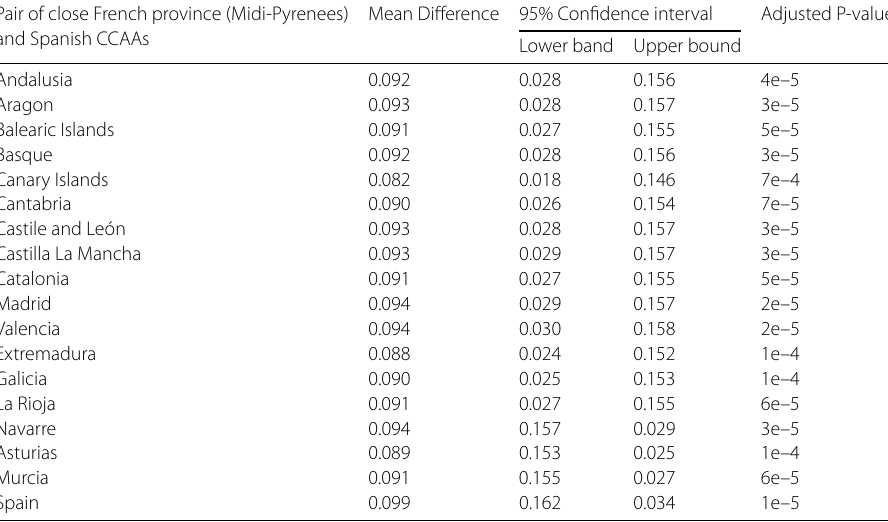
Mean Difference 95% Confidence interval